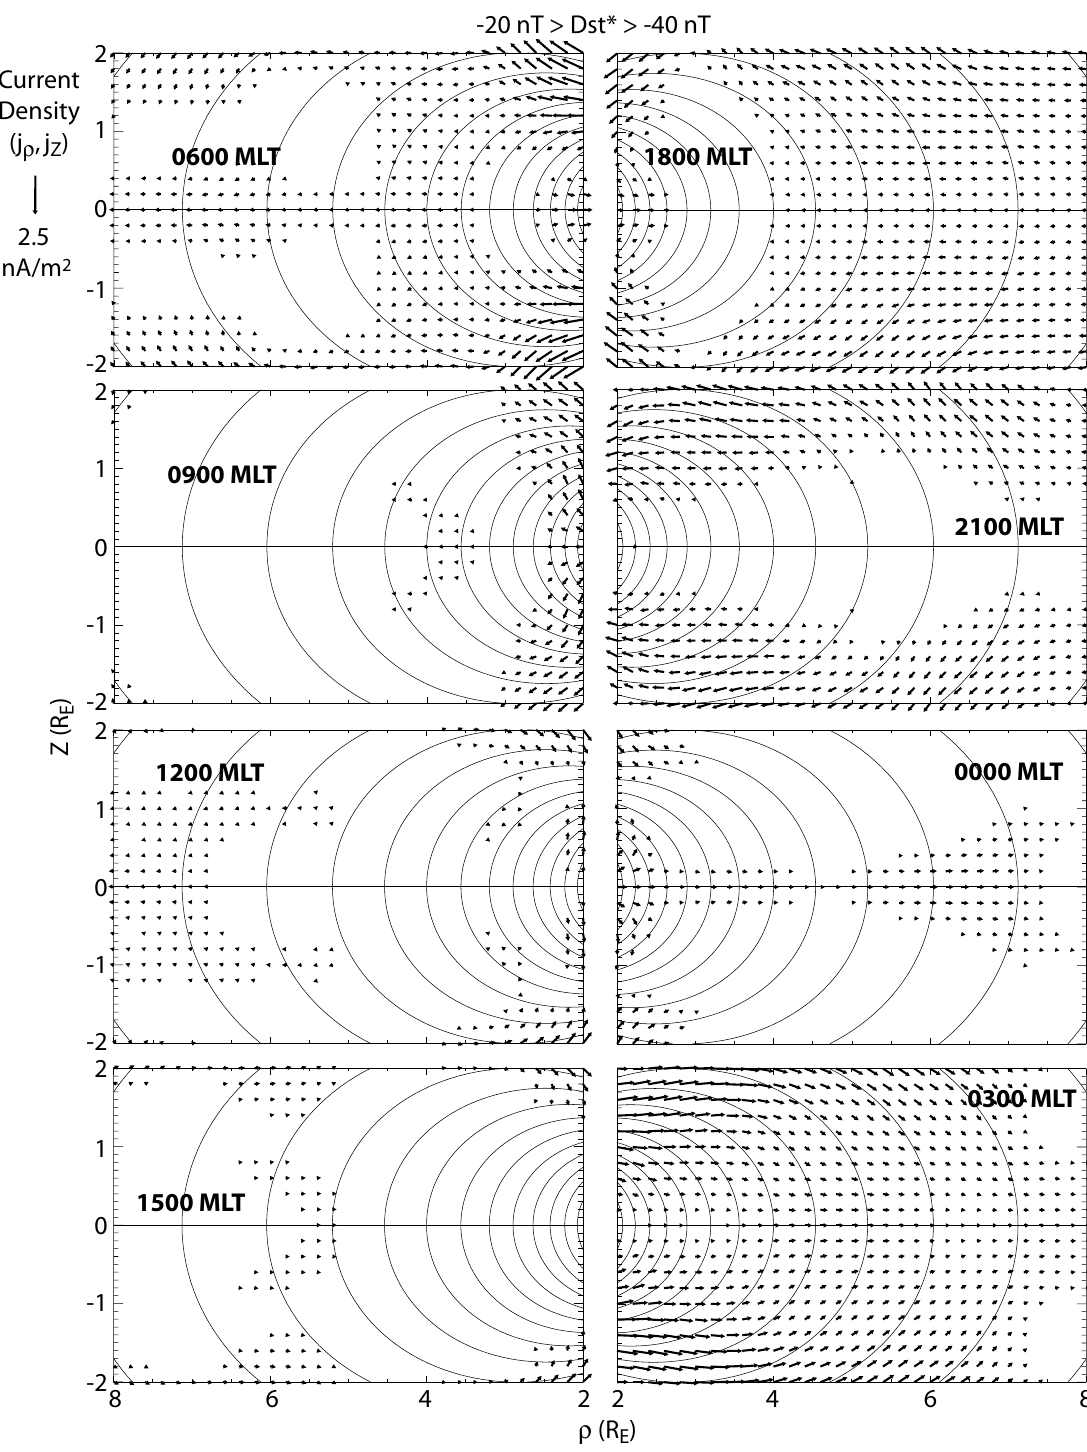
Fig. 10a. Meridional components of the current density as arrows in equally spaced grids in each of the 8 local time planes with superimposed dipole field lines for the four D st * levels. The scale factor for the current density is different for different D st *: (a) − 20nT >D st * > −